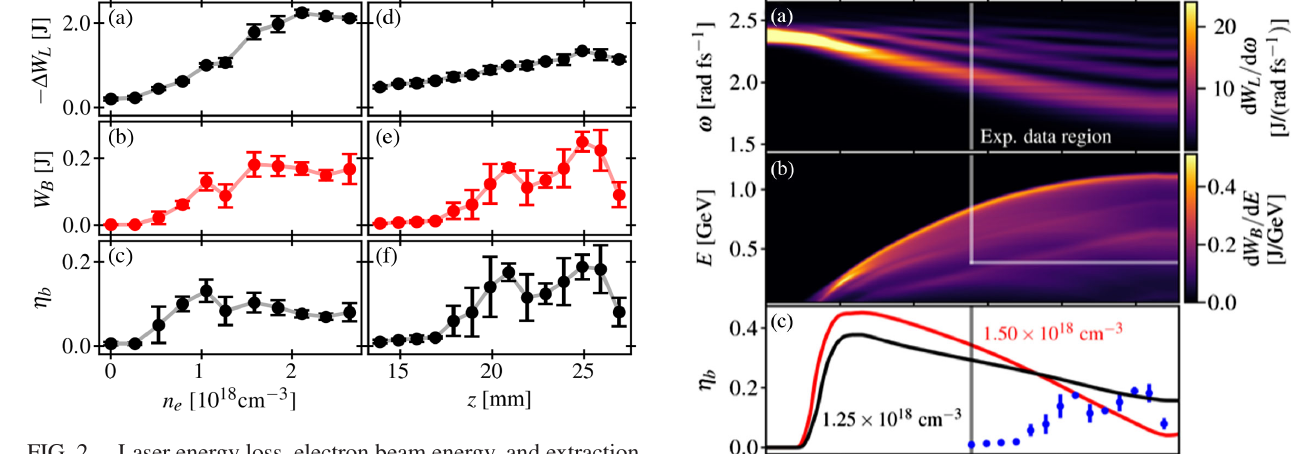
FIG. 2. Laser energy loss, electron beam energy, and extraction efficiency as functions of plasma density for z ¼ 27 mm (a) – (c), ¼ 1 . 25 × 10 18 cm − 3 . and length (d) – (f) with n e